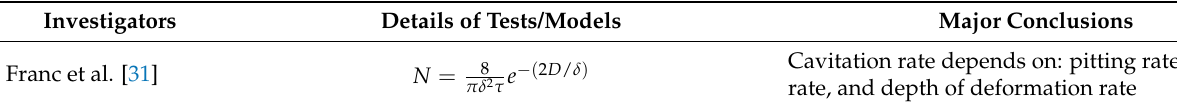
Table 2. Summary of some investigations on cavitation erosion.